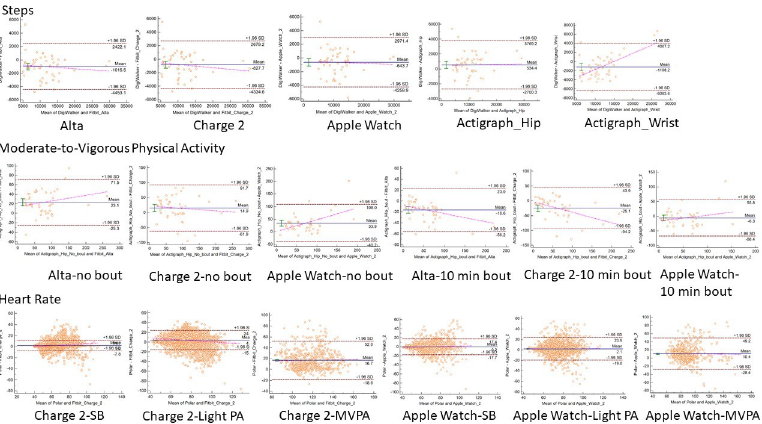
Fig 1. Agreement between criterion and comparison monitors on 95% equivalence